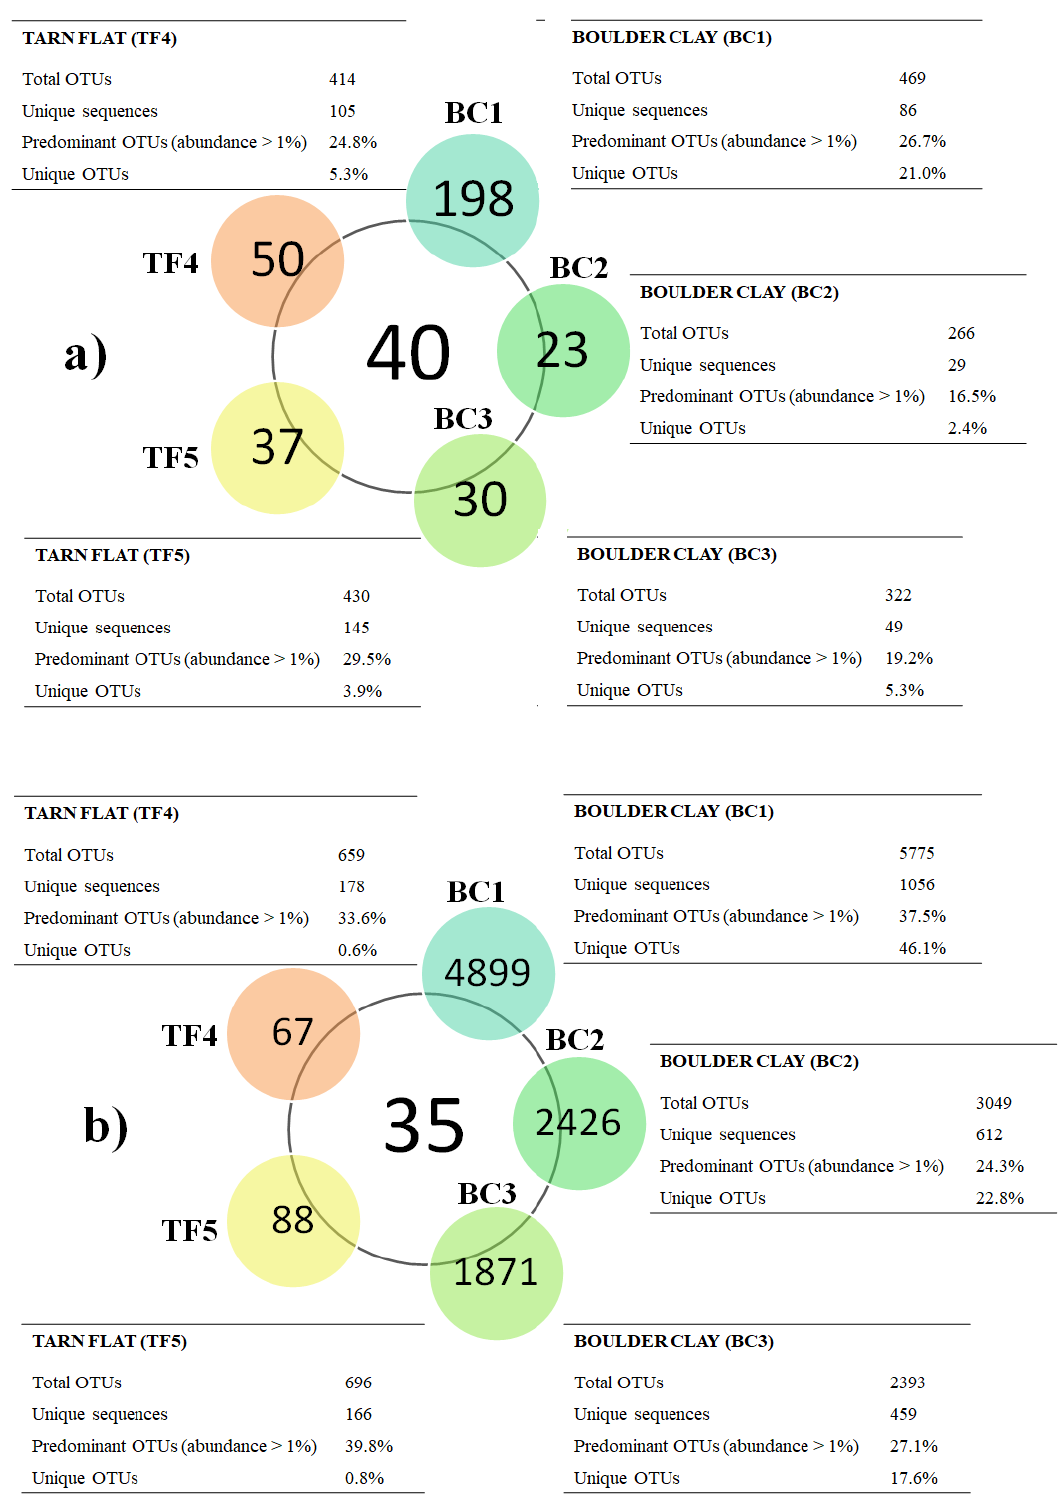
Figure 2. Diagram comparing bacterial ( a ) and archaeal ( b ) communities. Central circles show the number of OTUs shared among brines, while the lateral-colored circles report unique OTUs per brine. The number of total OTUs and unique sequences, as well as the percentages of the predominant and unique OTUs, for each brine, are shown in the tables, which are located close to the sample names.